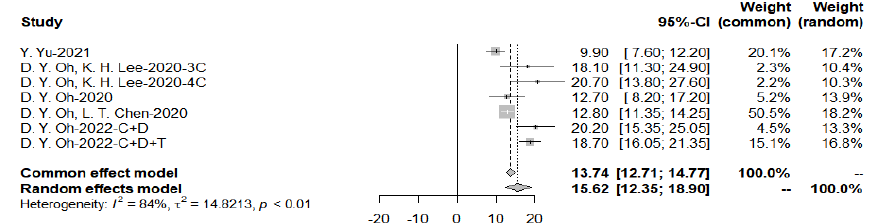
Figure 8. Pooled overall survival with immunotherapy combined with chemotherapy.